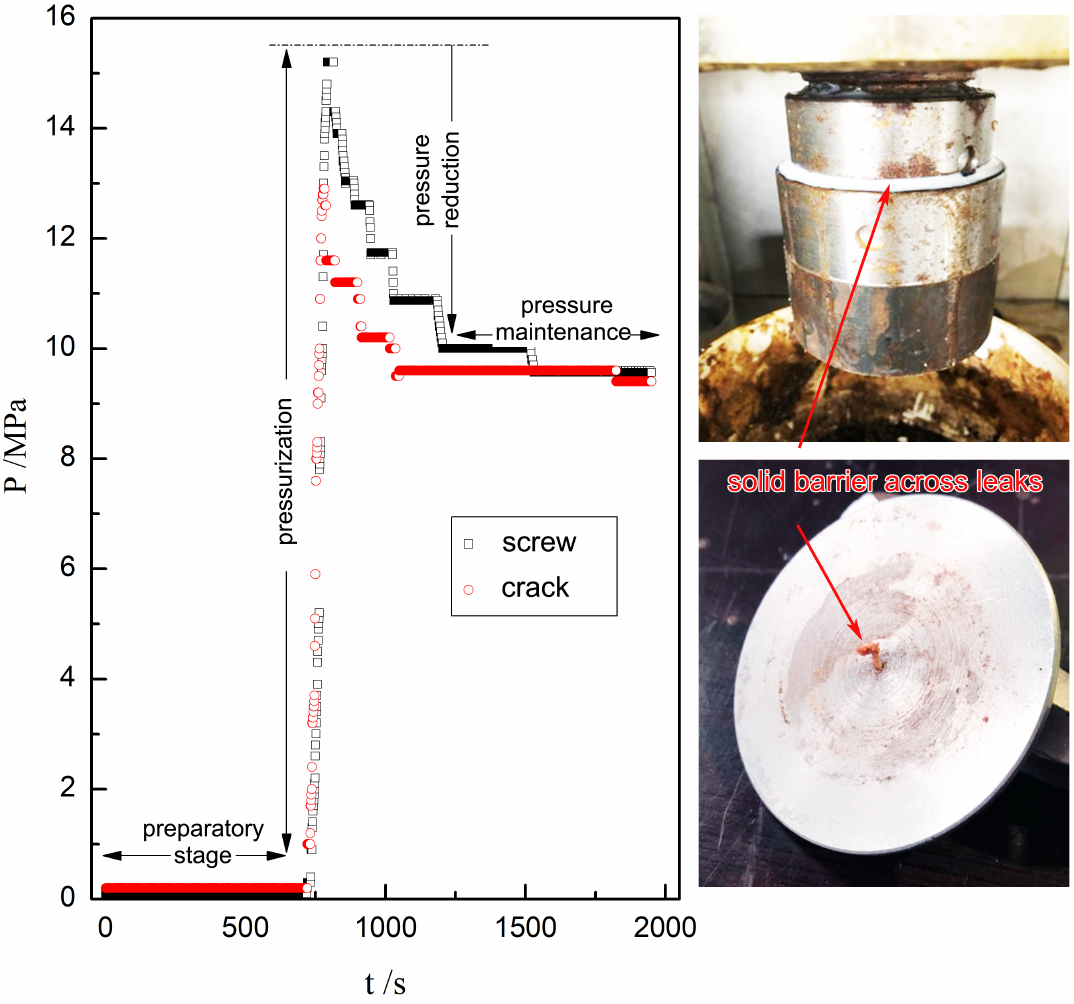
Figure 5. Dynamic sealing curves ( left ) and solid barrier images ( right ) of Sealant 0 in the di ff erent leaks. The right images show solid barriers formed through screw ( top ) and crack ( bottom ) defects. The relevant size of the crack is of 0.5 mm × 0.5 mm × 10